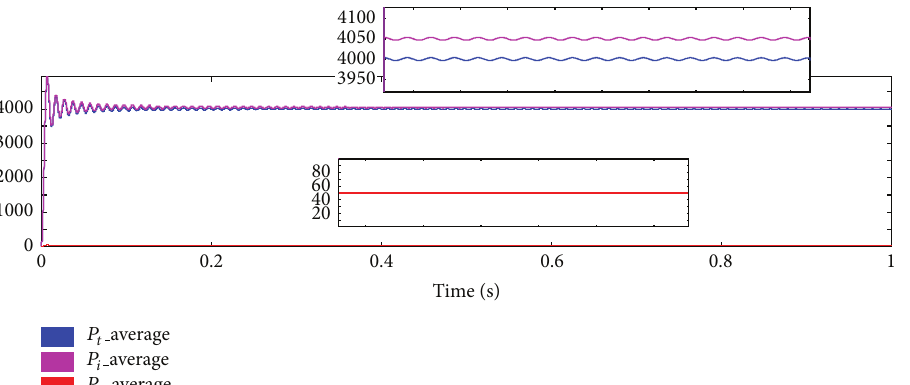
Figure 8: Average power for the 𝑉𝑅 circuit.